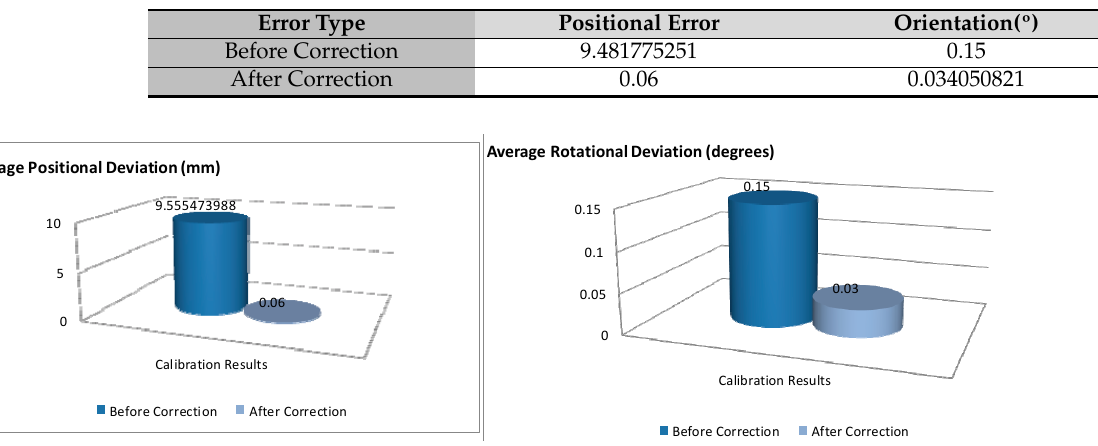
Figure 12. Error correction results (on fourth correction cycle) . Table 2. Positions (in tracker reference frame) before and after calibration.